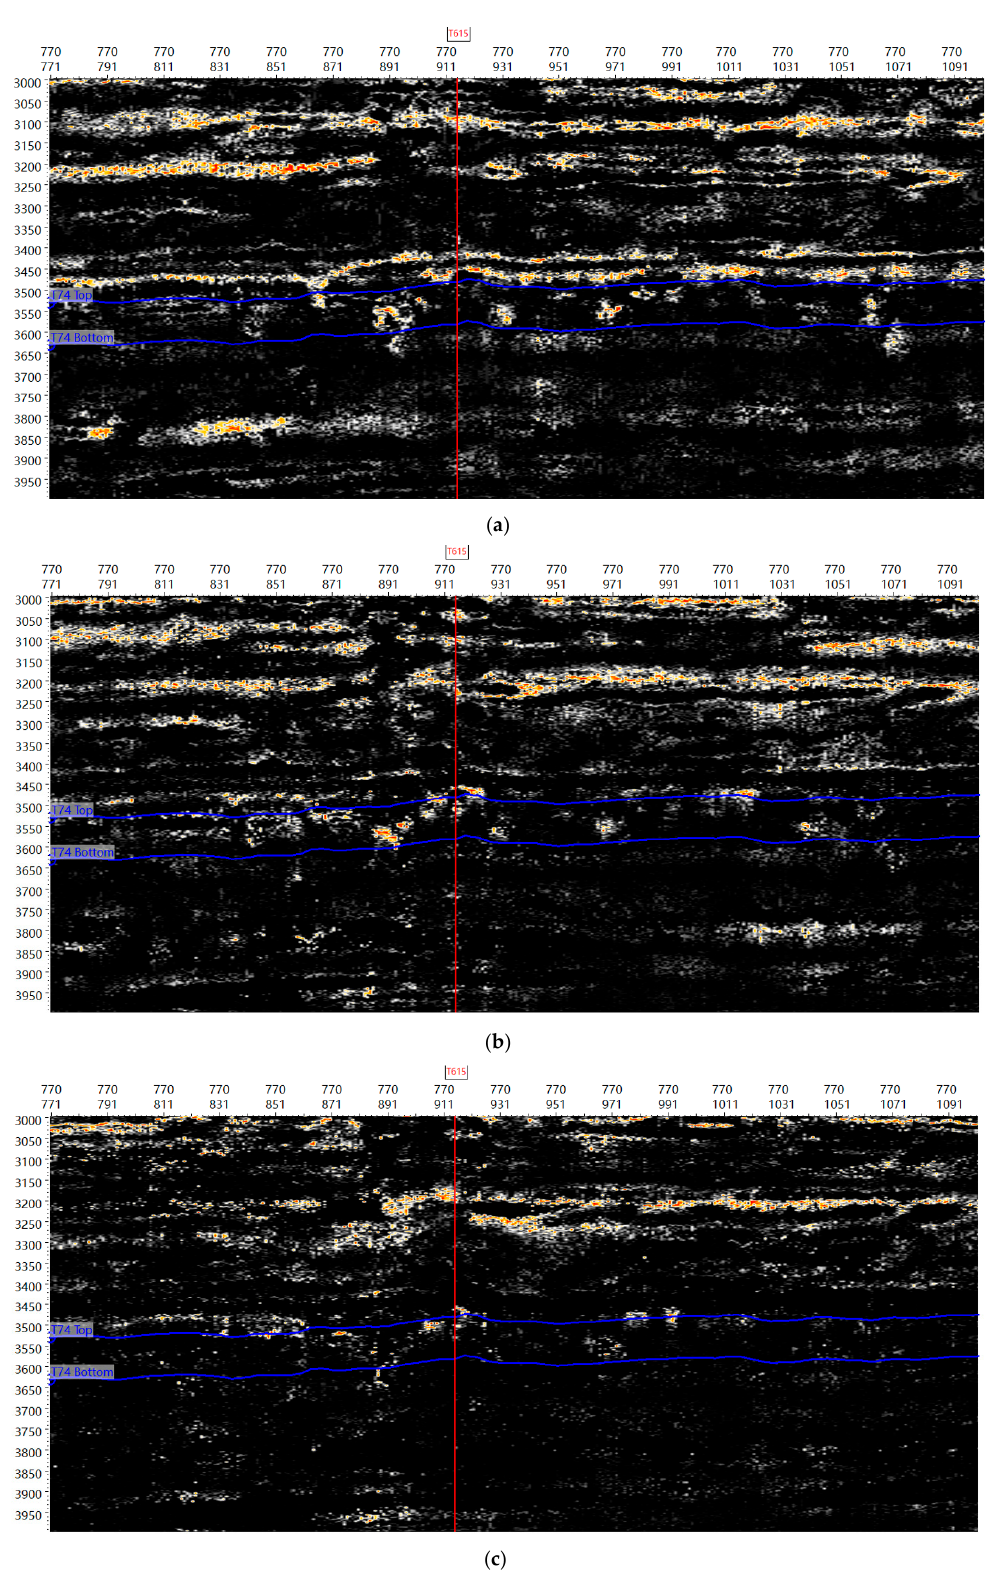
Figure 7. Constant-frequency slices, 30-Hz ( a ), 35-Hz ( b ), and 40-Hz ( c ) of the time–frequency map of the 2D seismic data cross Well T615 (Figure 3). The instantaneous spectrum of di ff erent frequencies shows di ff erent reservoir